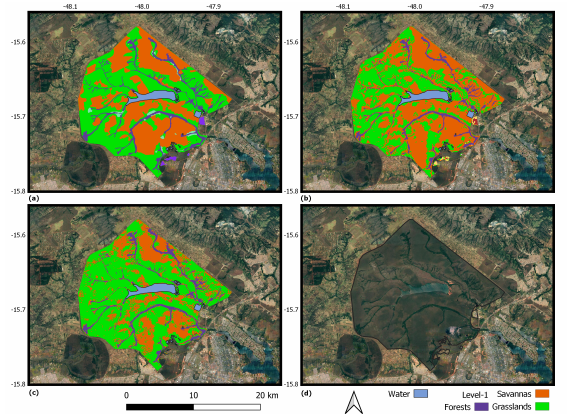
Figure 6. Map comparisons: a) Ferreira et al., 2003; b) Mapbiomas Collection 4.0; c) Our map; d) Google Satellite (April 7,